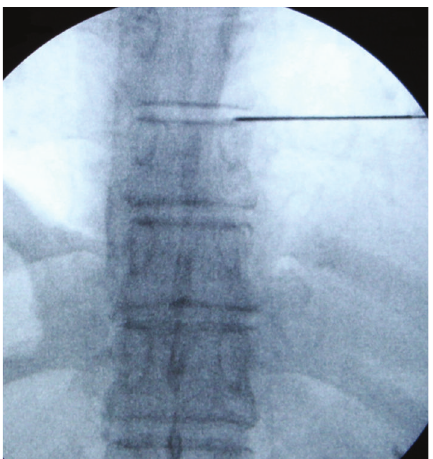
Figure2:Discographywasperformedtoconfirmthetargetdiscand to help identify thelocation of theherniation; theneedle was parallel to the upper endplate of the lower vertebral